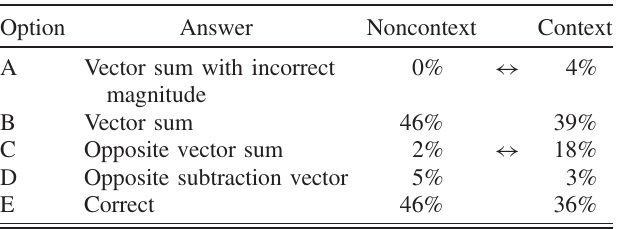
TABLE XIV. Results of item 12: Students have to choose the representation of the vector difference or change of velocity vector in 1D. Arrows indicate significant